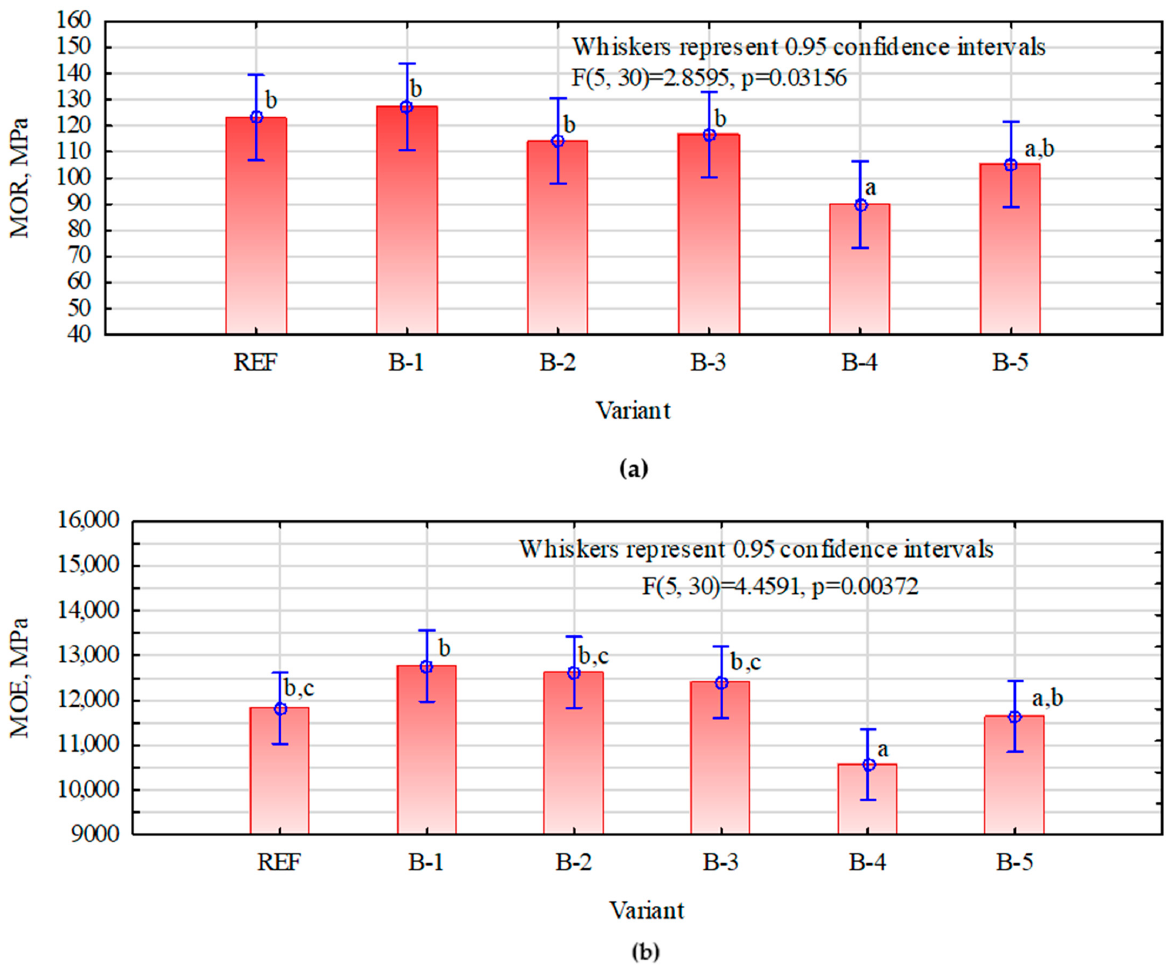
Figure 3. The results of MOR ( a ) and MOE ( b ) tests in longitudinal direction. The lowercase letters means homogeneous groups.